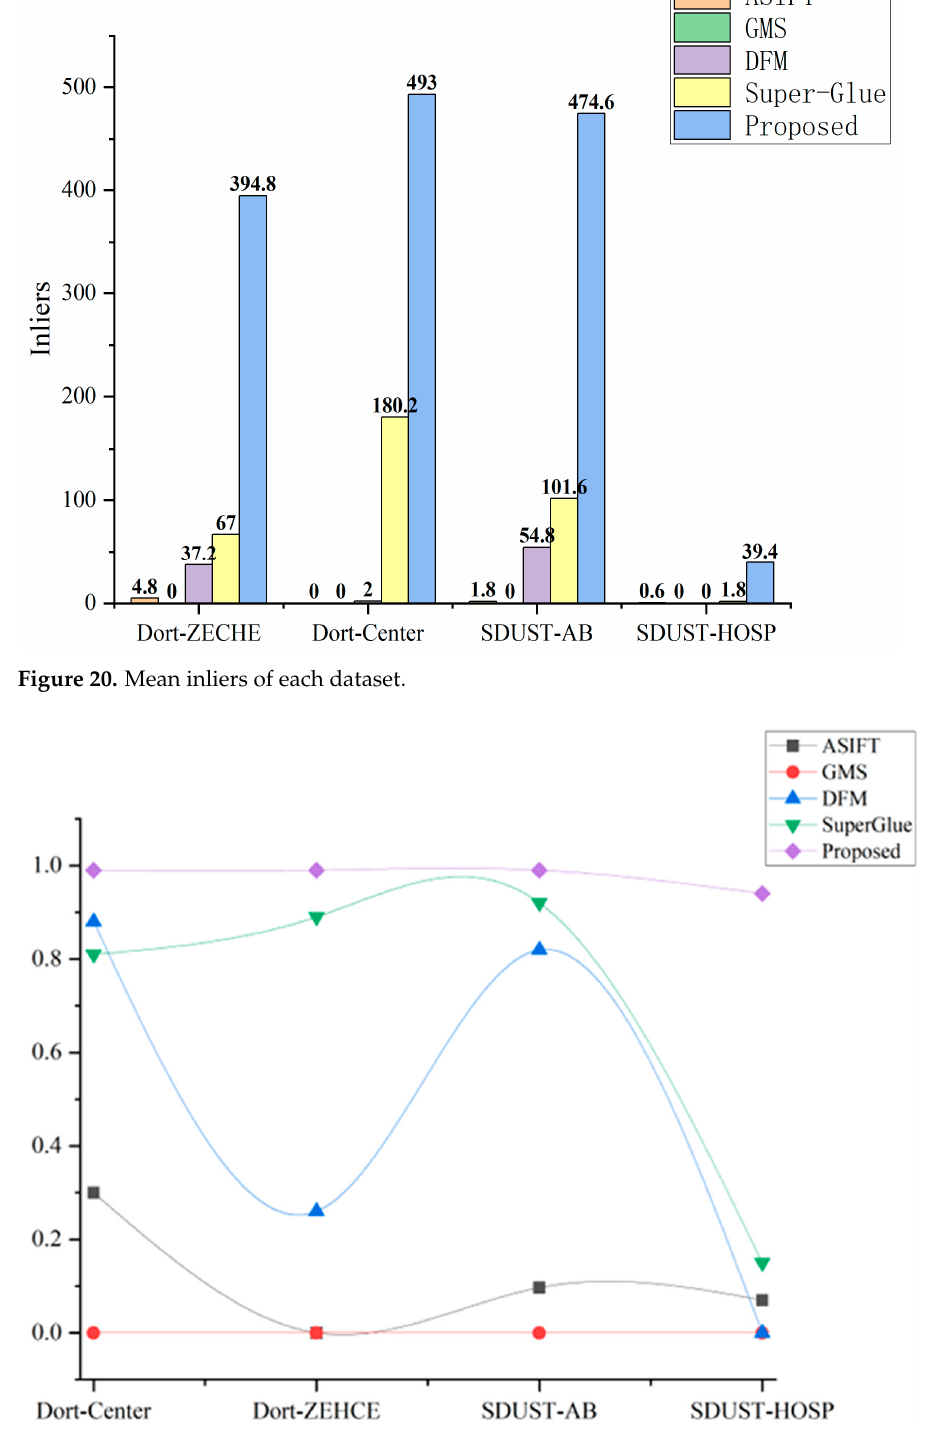
Figure 21. Mean matching accuracy of each dataset.